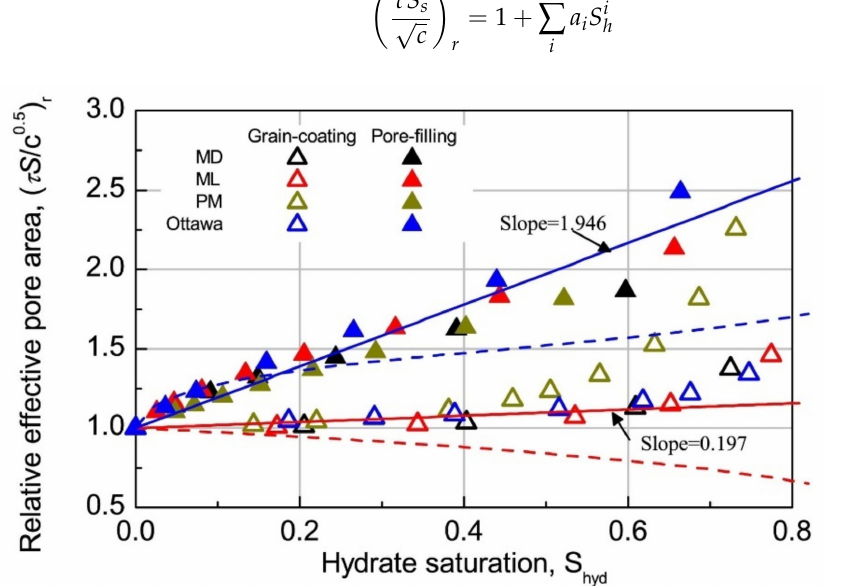
Figure 8. Relative effective pore area for the noncapillary effect. The dashed lines are obtained from KGM for the grain-coating (red color) and pore-filling (blue color) cases. Reprinted with permission from Ref. [53]. Copyright 2022 American Geophysical Union. Note: Please refer to the original literature for the experimental data points shown in the